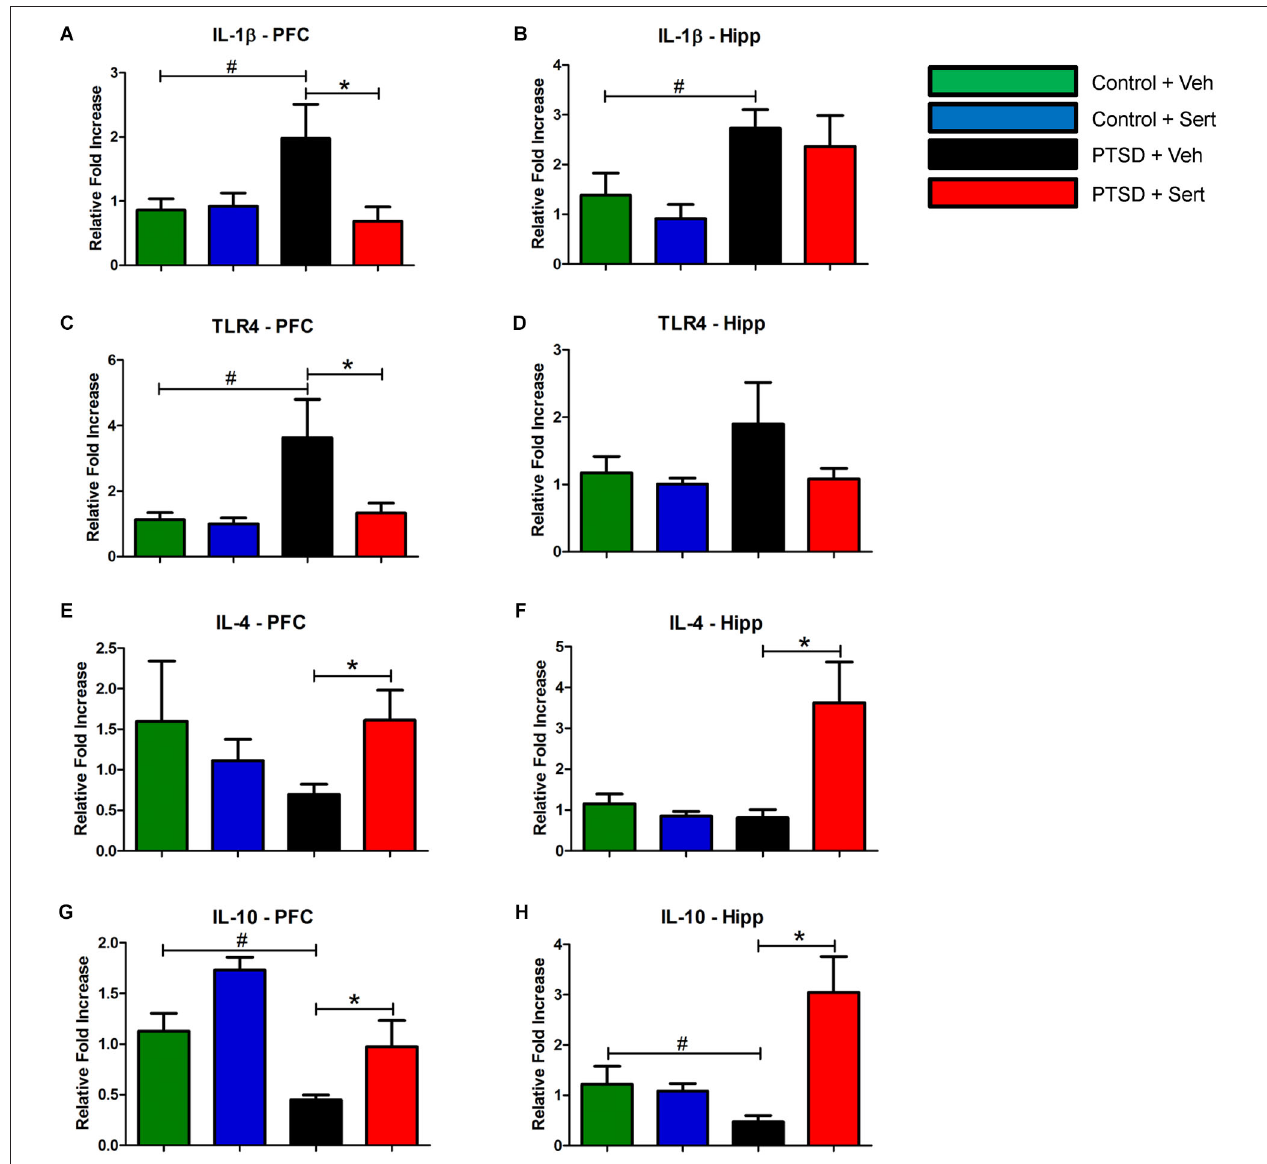
administration normalized the elevated PIC mRNA and up-regulated anti-inflammatory cytokine (AIC) to levels similar to or higher than the control + Veh group. All data are presented as mean ± SEM. * p < 0.05 between the PTSD groups. # p < 0.05 between the vehicle